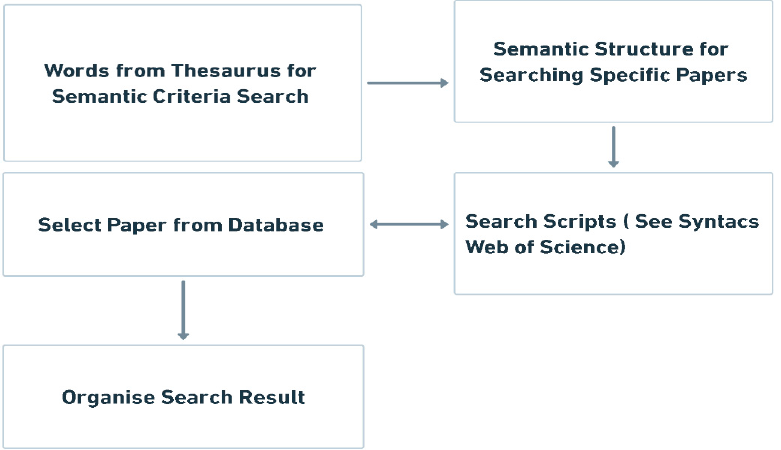
Figure 1. Systematic Literature Review search procedure (adapted from Kitchenham et al., 2019 [23]).